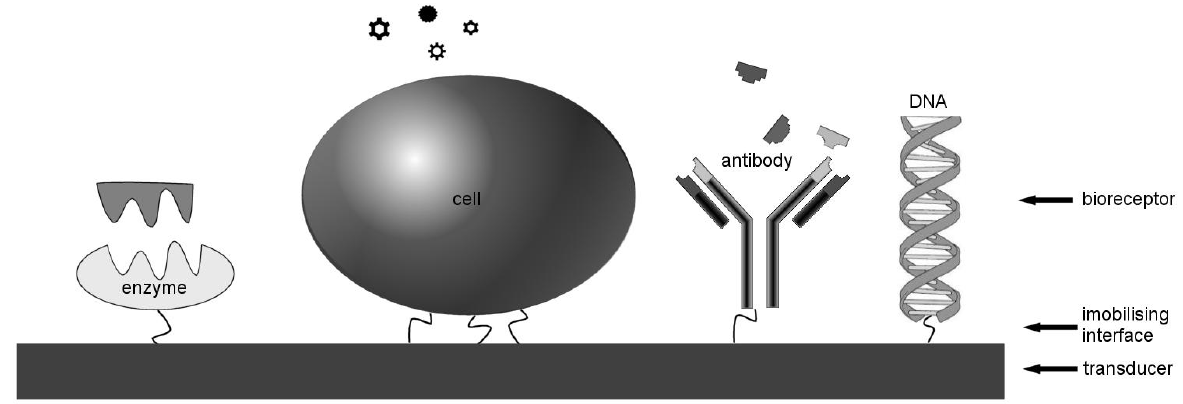
Figure 1. Elements of a biosensor. Various biological elements may form the bioreceptor which are immobilised on the transducer (adapted from